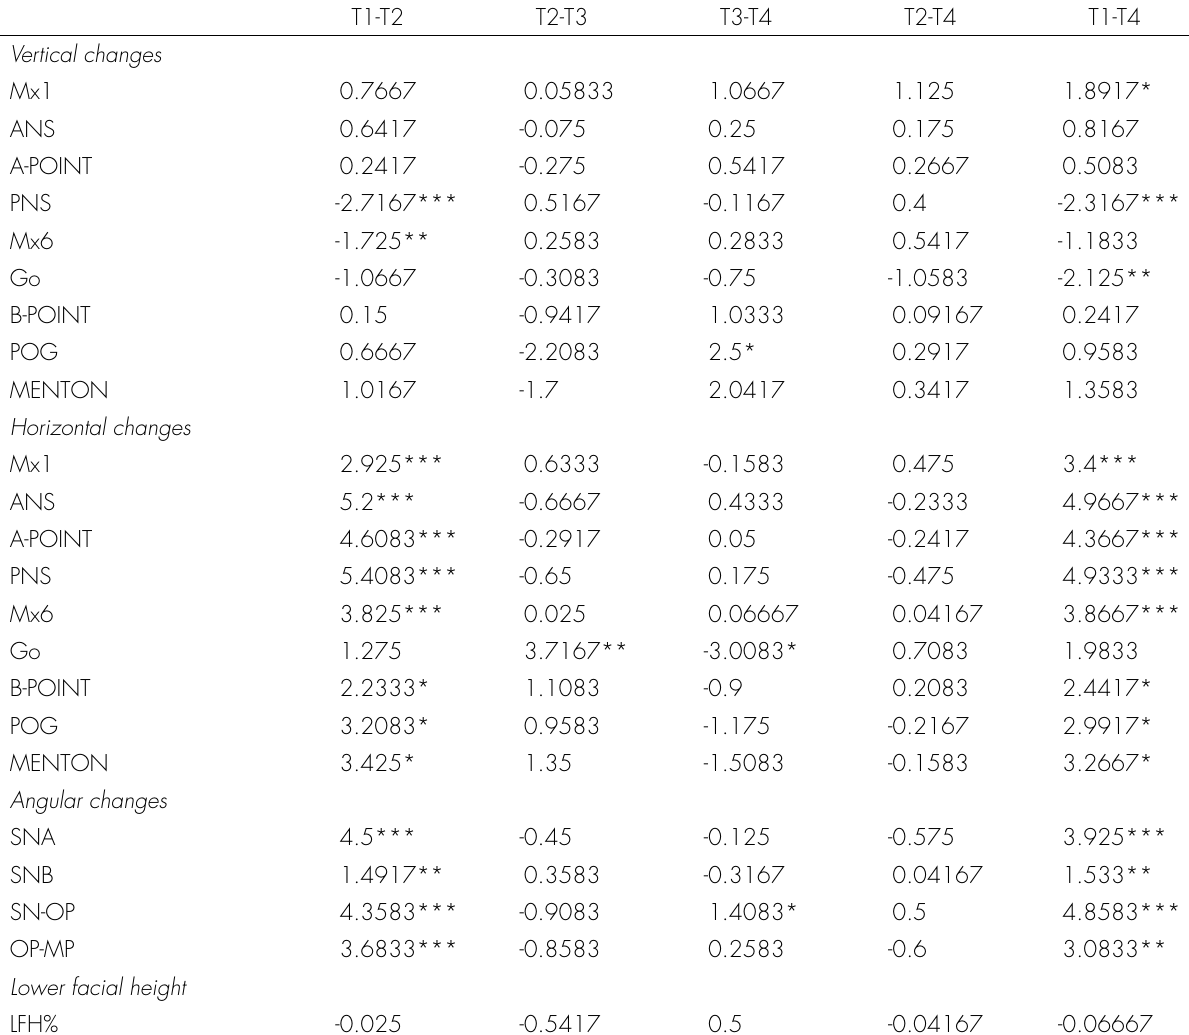
Table III. Group 2: Clockwise Rotation